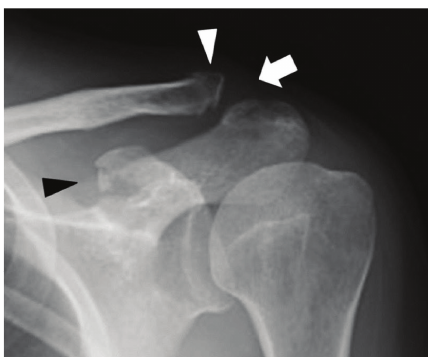
Figure 1: Radiograph showing an ACJ dislocation (white arrow) with distal clavicle fragment displaced upwards (white arrowhead). Upon close examination, a cortical bone discontinuity at the CP medial apex is observed (black arrowhead).